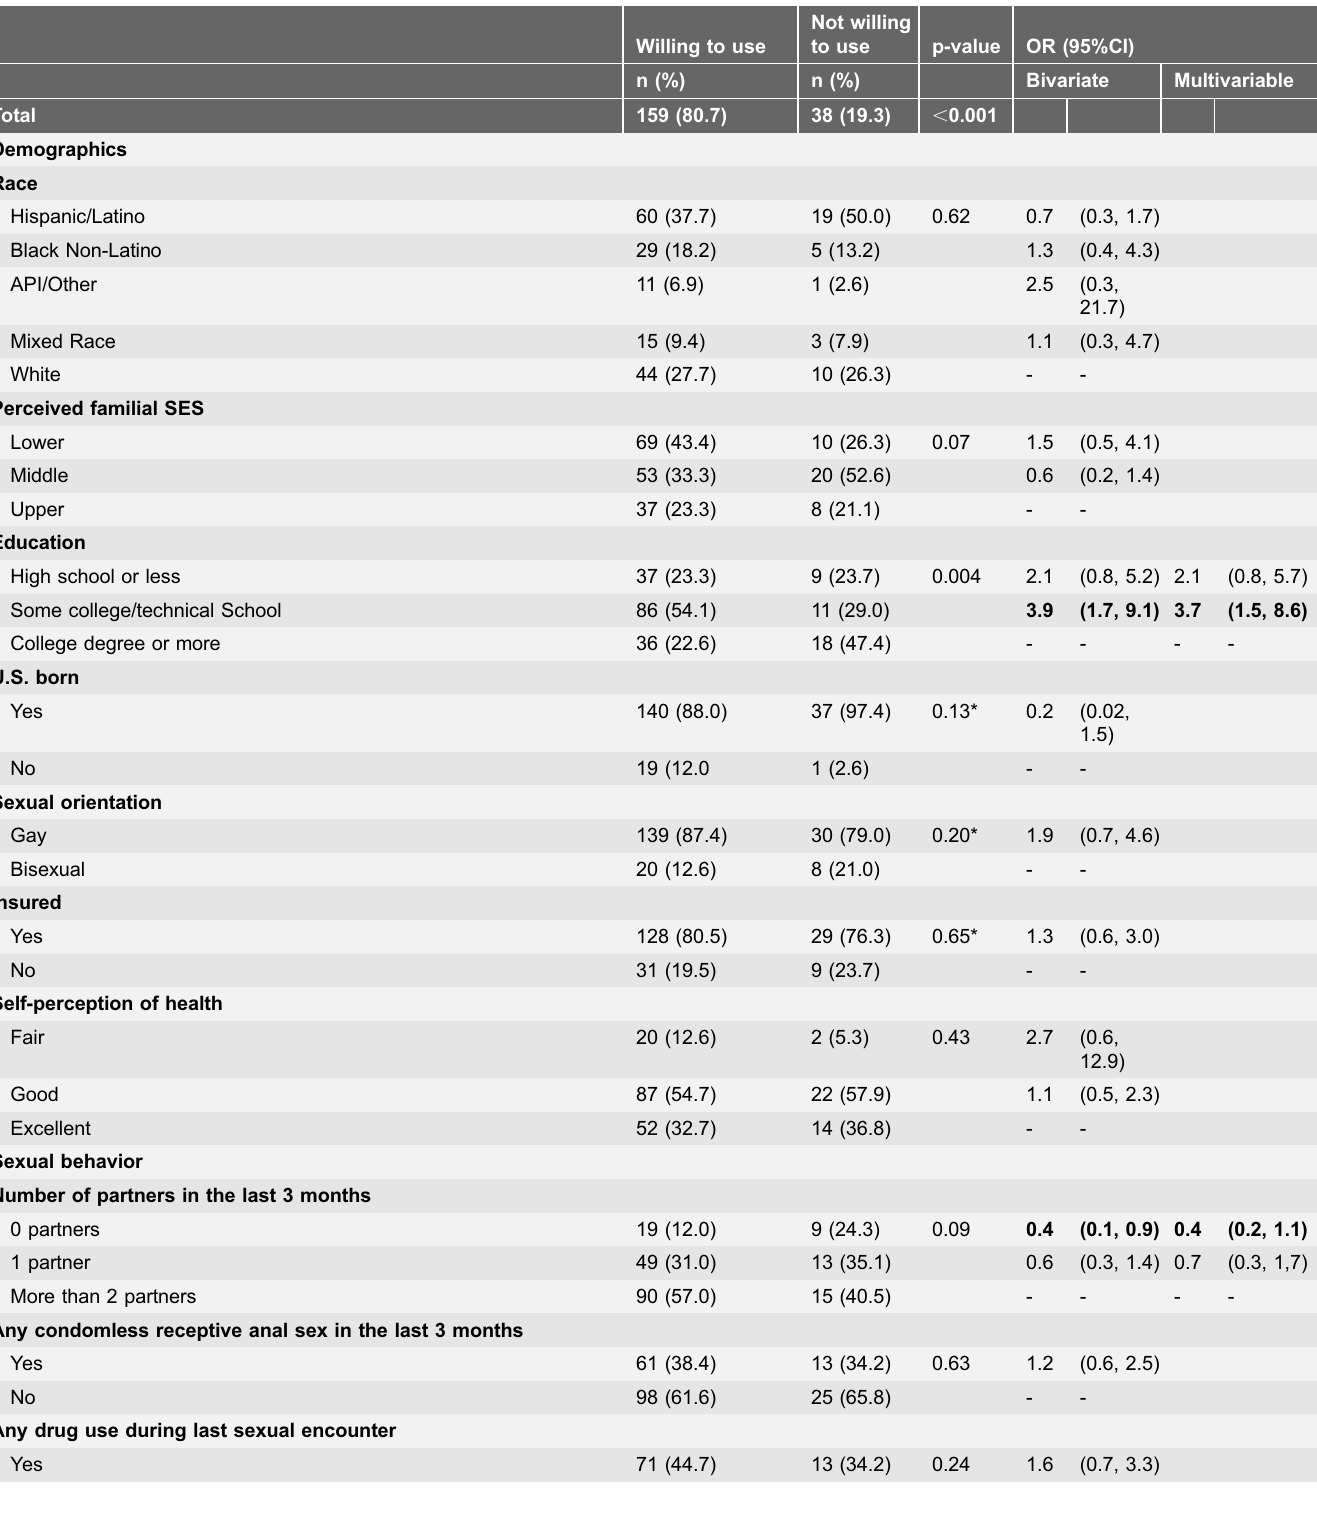
Table 2. Willingness to use LAI-PrEP by demographics and sexual behavior (n 5 197) and bivariate and multivariable analysis of willingness to use LAI-PrEP (n 5